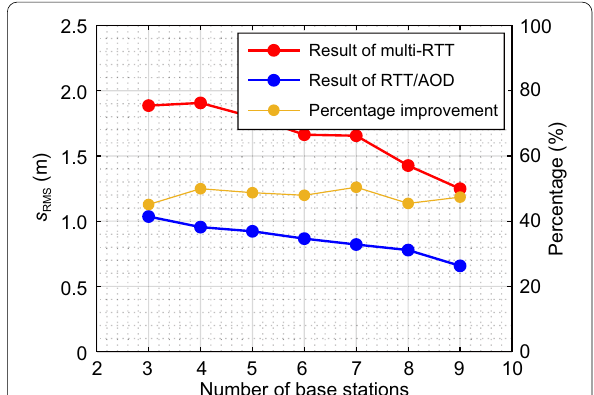
Fig. 9 Variation of RMS with the number of base stations